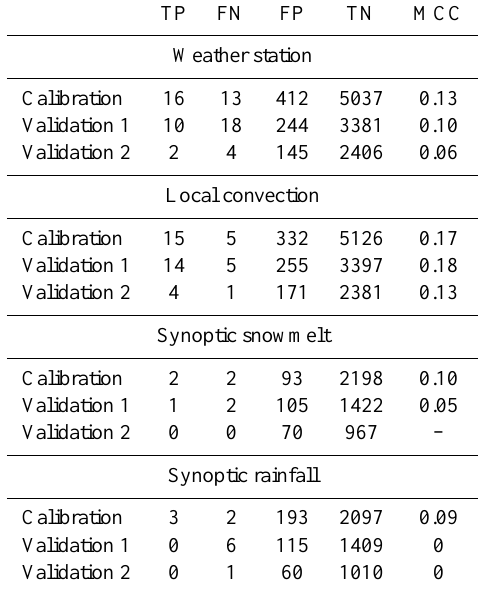
Table 4. Results for the static threshold for the calibration period (1989–2003) and validation period 1 (1979–1988) and validation period 2 (2004–2010). The total number of days (TP + FN + FP + TN) is the same for the weather station and lo- cal convection. The number is lower for Ss and Sr, as they are only applied over spring and summer